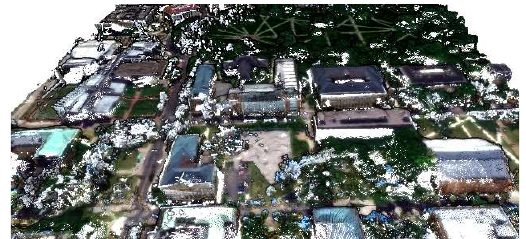
Figure 12. Co-registered street-view and satellite view dense match